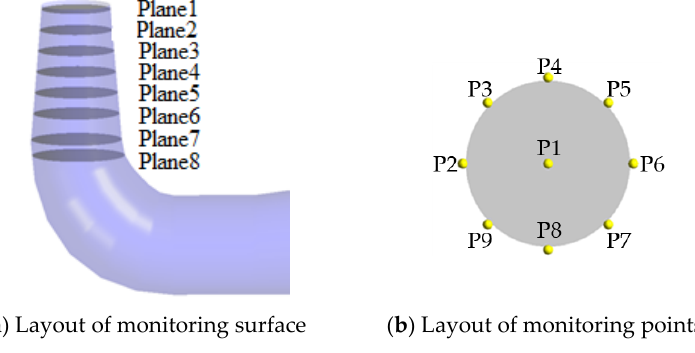
Figure 2. Distribution of the measuring points in the draft tube. Table 2. Detailed statistics of the monitoring section.